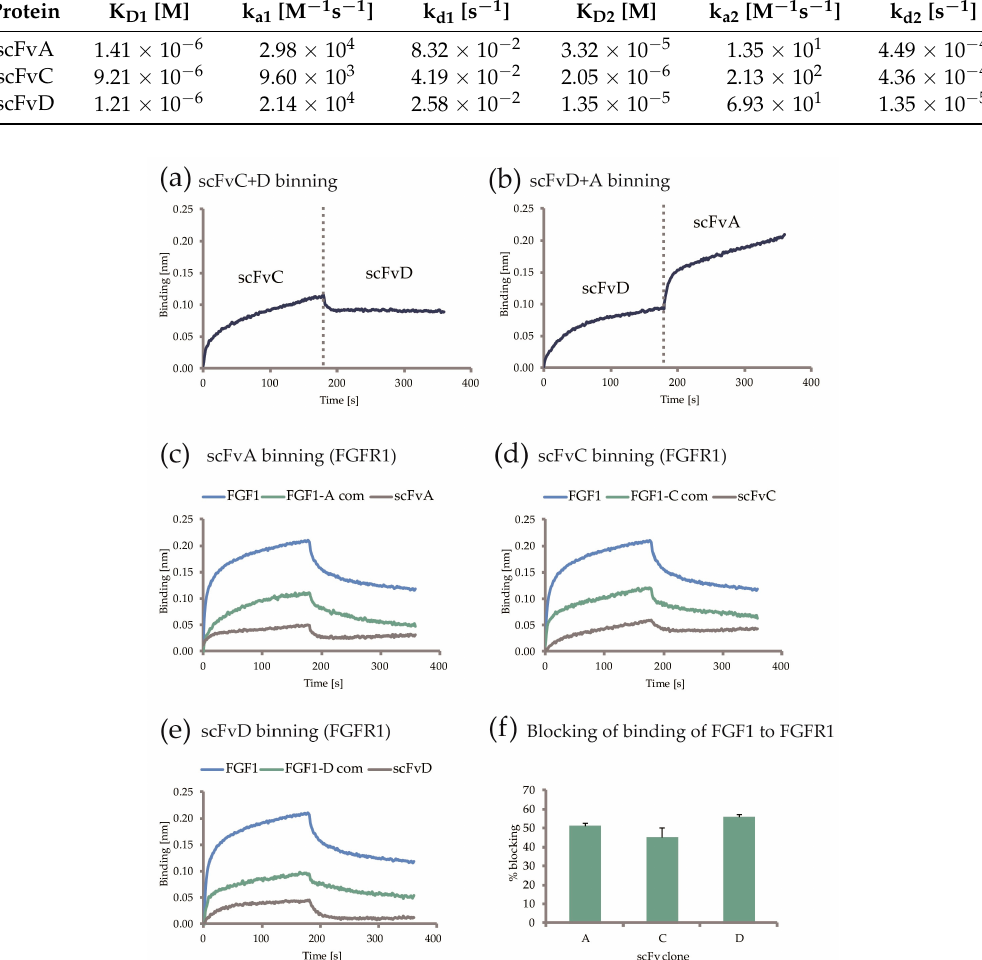
Figure 6. Epitope binning of selected scFvs with FGF1 and ECD_FGFR1-Fc. ( a , b ) Representative sensograms showing binding of subsequent scFvs to FGF1 immobilized on the sensor. scFvC blocking the ability of scFvD to bind FGF1, and scFvA binding FGF1 in the presence of scFvD; ( c – e ) Binding of FGF1 (blue), FGF1-scFv complex (green), and scFv (grey) to ECD_FGFR1-Fc immobilized on the sensor; ( f ) Percent of blocking of FGF1 binding to ECD_FGFR1-Fc by the selected antibody fragments. The error bars indicate standard deviation.